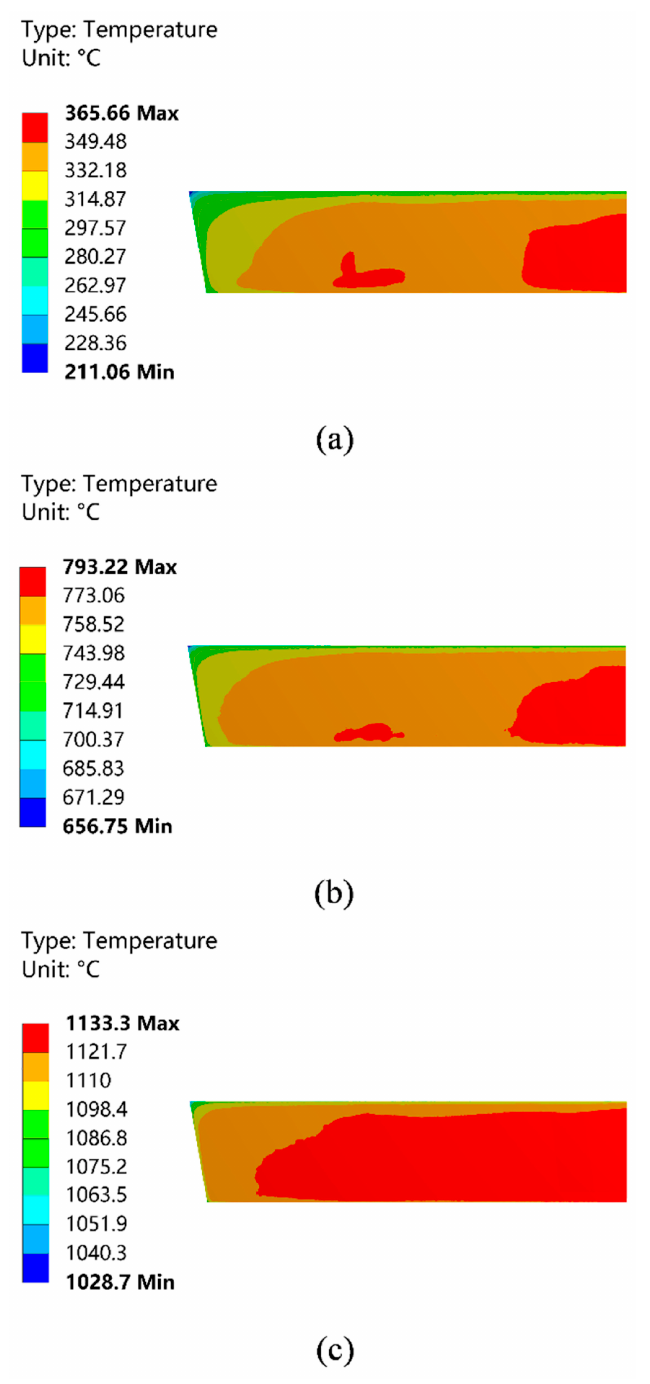
Figure 2. Temperature field distribution of the hot surface of the working layer. ( a ) The first stage of preheating; ( b ) the second stage of preheating; and ( c ) the third stage of preheating.